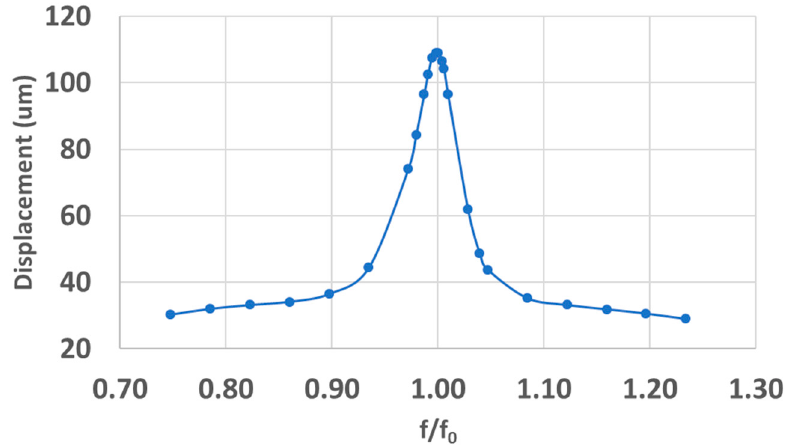
Figure 9. Typical harmonic response of a 100-µm-tall aluminum bridge sample with a natural frequency of 2381 Hz (50% duty cycle).